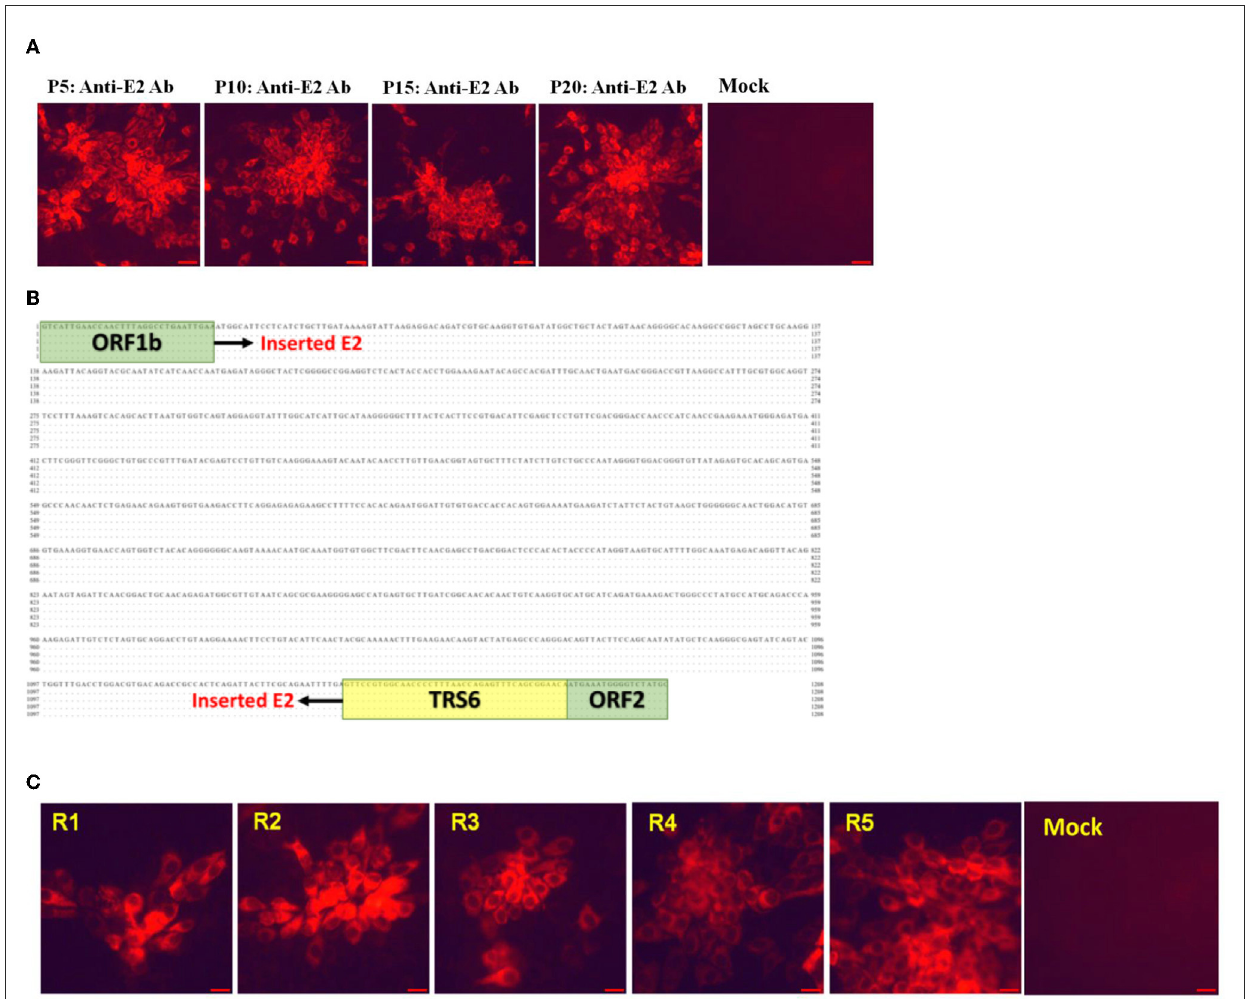
FIGURE2 The genetic stability of foreign genes in rPRRSV-E2 in vitro and in vivo . (A) Indirect immunofluorescence results of CSFV E2 protein of in vitro generation of P5, P10, P15, and P20 viruses. (B) Sequence alignments of CSFV E2 protein insertion region of the isolated virus of various passages in vivo . (C) Indirect immunofluorescence assay of CSFV E2 protein expression of the isolated virus after passage in vivo . Scale bar = 20 µ